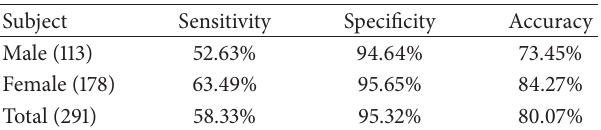
Table 3: Sensitivity, specificity, and accuracy when comparing sphygmomanometer and wrist